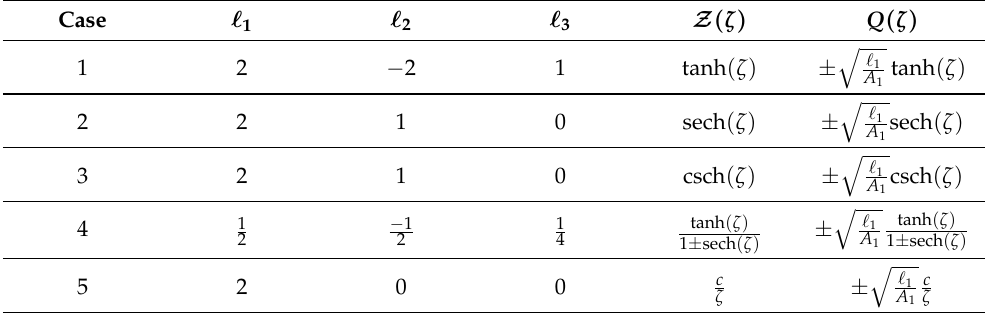
Table 3. All possible solutions for wave Equation (12) when (cid:96) 1 > 0 and m → 1. Case